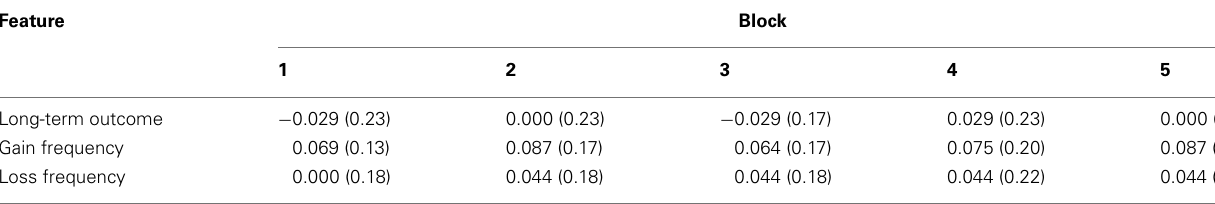
Table 5 | Median weights calculated for the five consecutive blocks (á 20 choices) of the Iowa GamblingTask. Feature